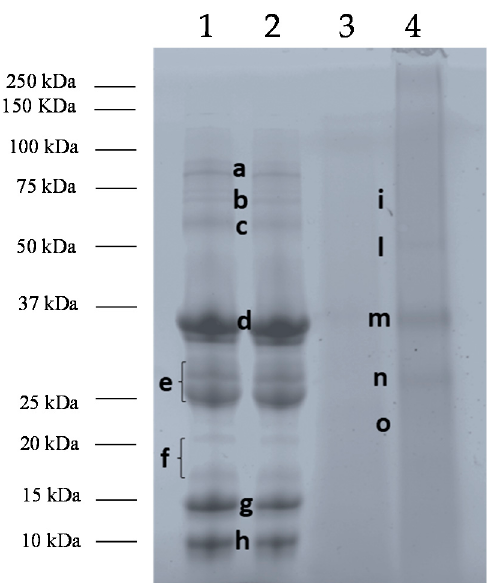
Figure 1. SDS-PAGE of cow’s milk (CM) submitted to the different treatments: Pasteurized CM (Lane 1), baked CM at 180 °C for 10 min (Lane 2), blank muffin (Lane 3) and CM incurred muffin (Lane 4).